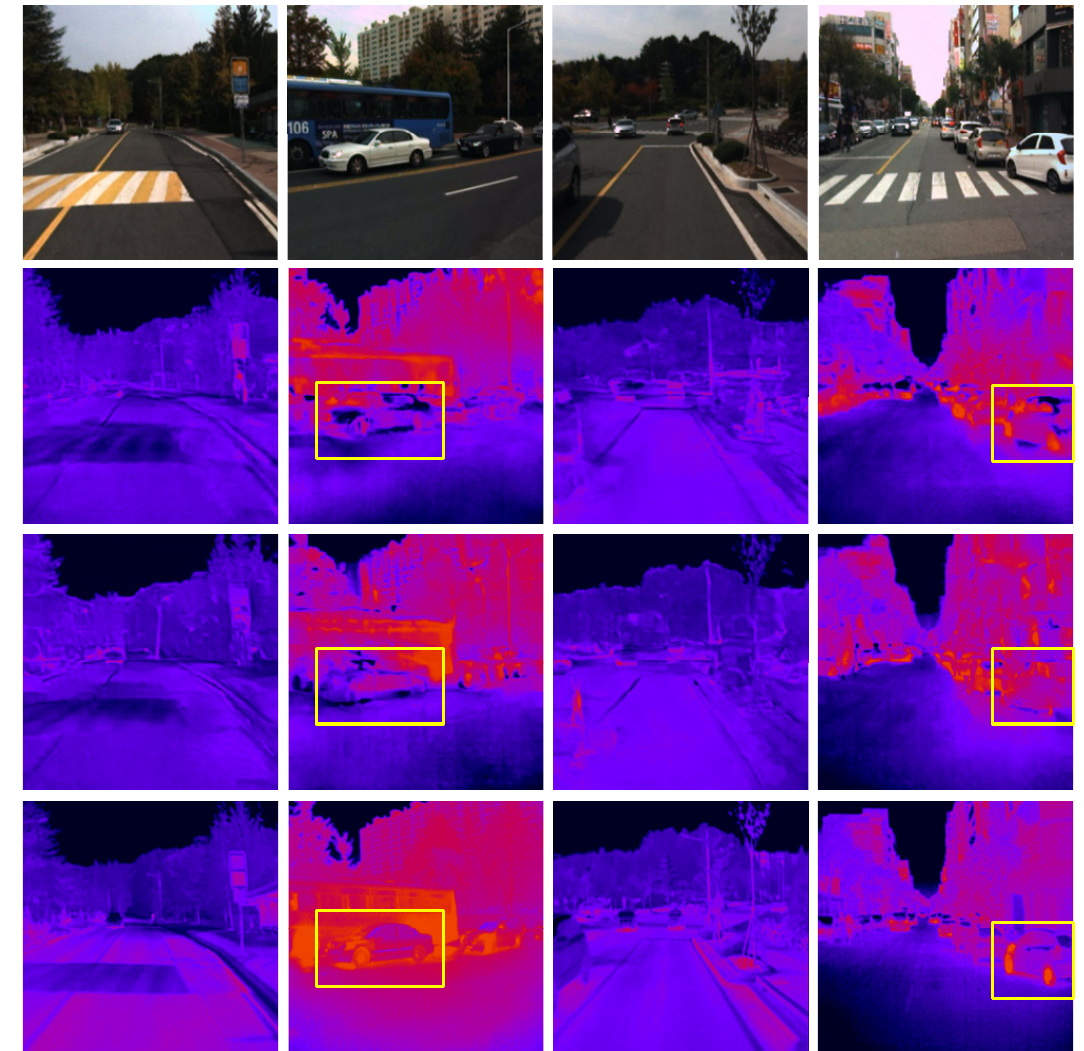
Figure 8. Comparison of two-level and three-level networks’ visualization results.